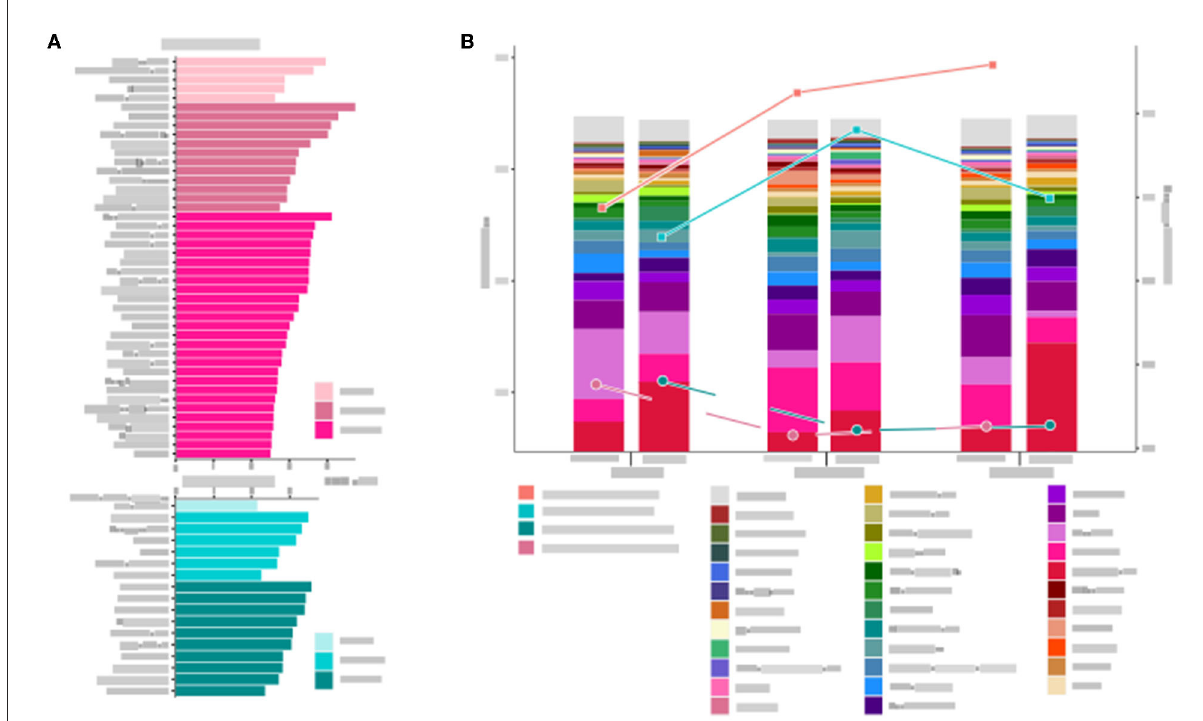
FIGURE5 Microbial structure and diversity of the gut microbiota in the general diet group and liquid diet group at three timepoints are analyzed. (A) Changes in genera at three timepoints. (B) The stacked bars show microbial composition at the genus level, and the trend of α - and β - diversity at three timepoints are presented by Shannon index and Brat–Curtis distance,